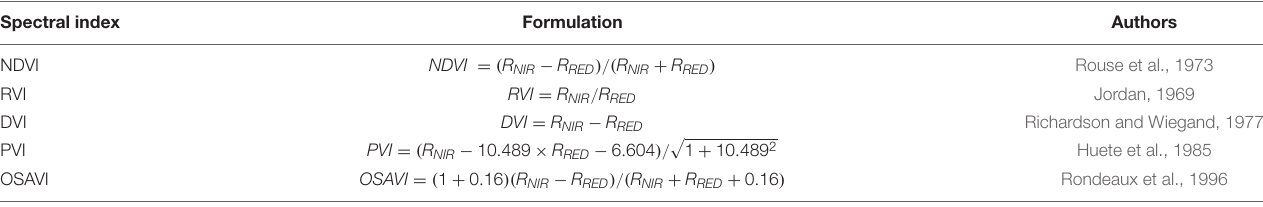
TABLE 1 | The calculation of the vegetation indexes.